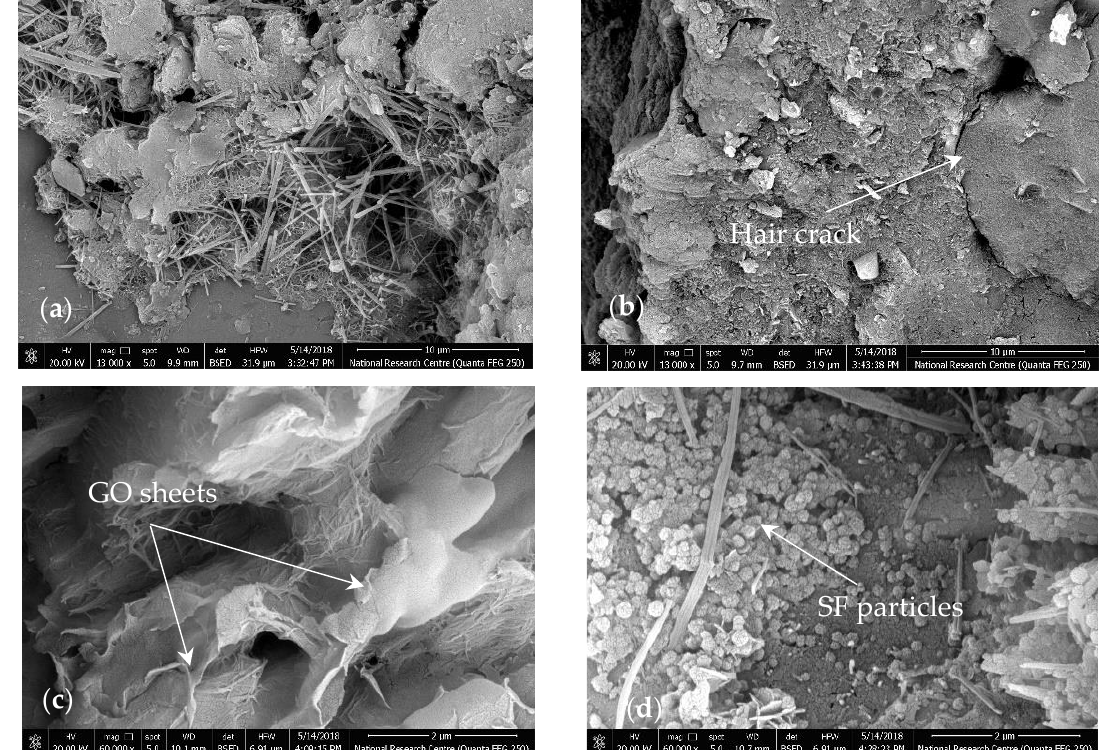
Figure 7. SEM images of the fracture surface at the age of 28 days: ( a ) sample S0G0; ( b ) sample S5G0; ( c ) sample S5G3; ( d ) sample S5G9.